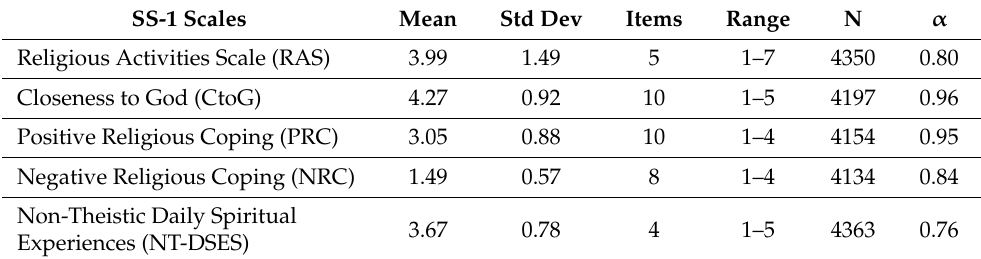
Table 3. Characteristics and Internal Consistency of the SS-1